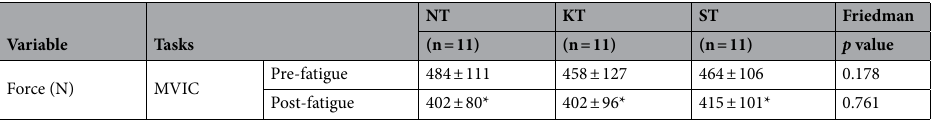
Table 1. Maximum isometric plantar flexion force. Data are presented as means + SD. NT No taping; KT Kinesio taping; ST Sham taping; SD Standard deviation; MVIC Maximum voluntary isometric contraction. *Statistically significant difference pre- and post-fatigue (Wilcoxon signed-rank test, p < 0.05).